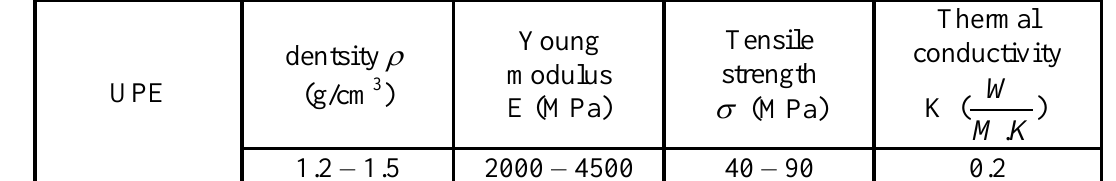
Table 1 : The physical properties of unsaturated polyester resins (UPE).